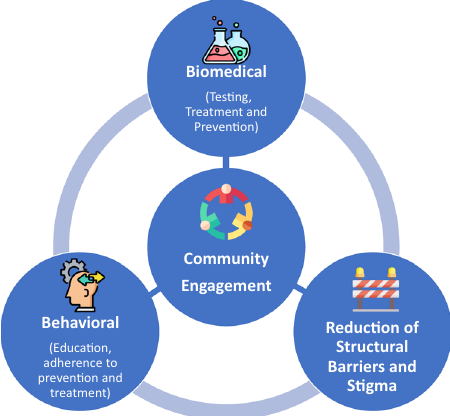
Fig. 1 A combination prevention toolbox has applications both for HIV and COVID-19. For both HIV and COVID-19, a combination prevention toolbox has the potential to reduce the transmission and number of new infections to control the